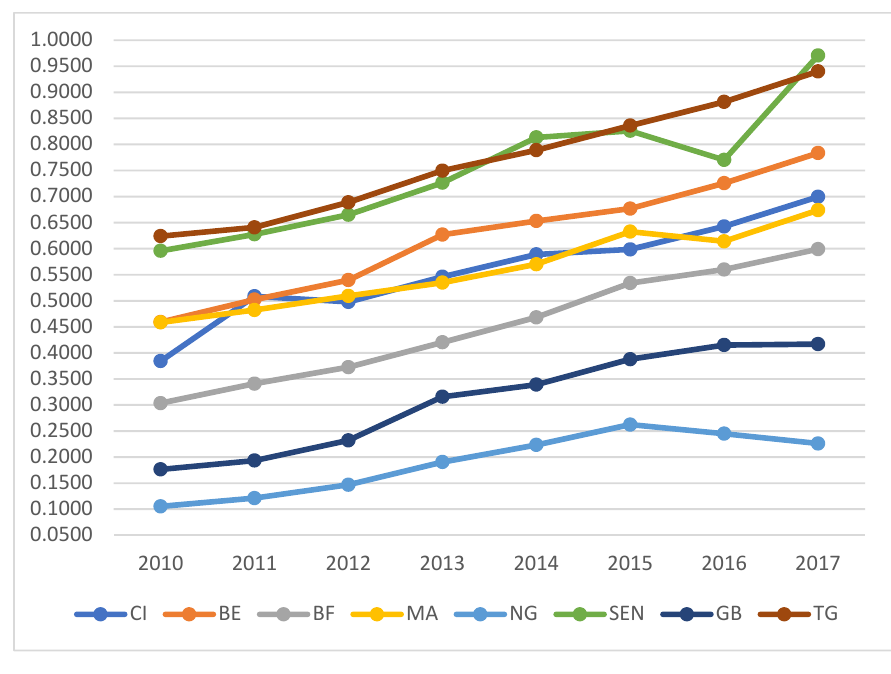
Figure 4. AS–CEB from 2010 to 2017.